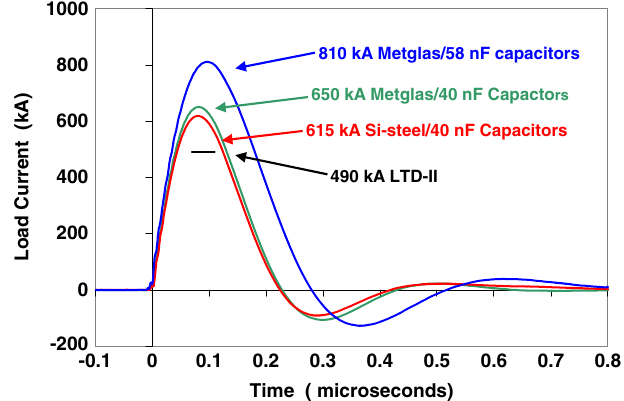
FIG. 10. Loss currents for the three experiments. A scaled current trace for one of the main current waveforms is shown for comparison.